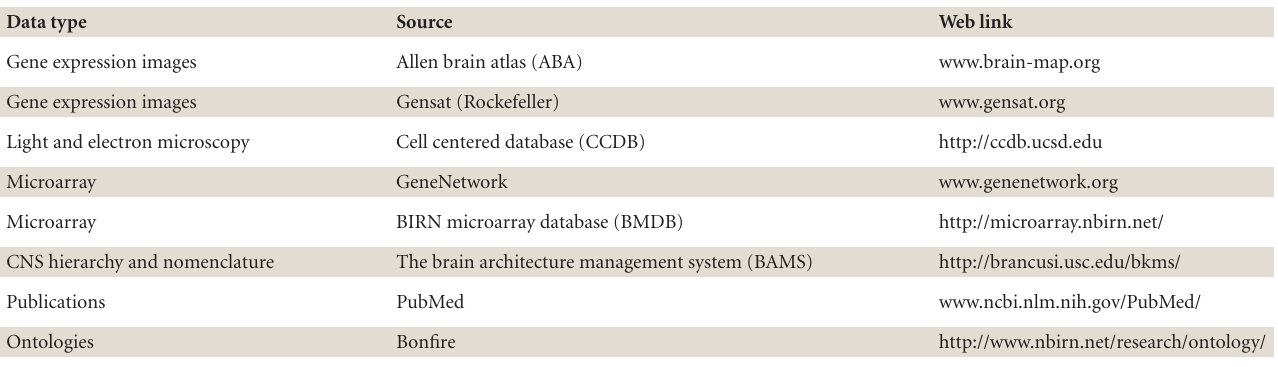
Table 1 | Data sources currently queried and accessed by